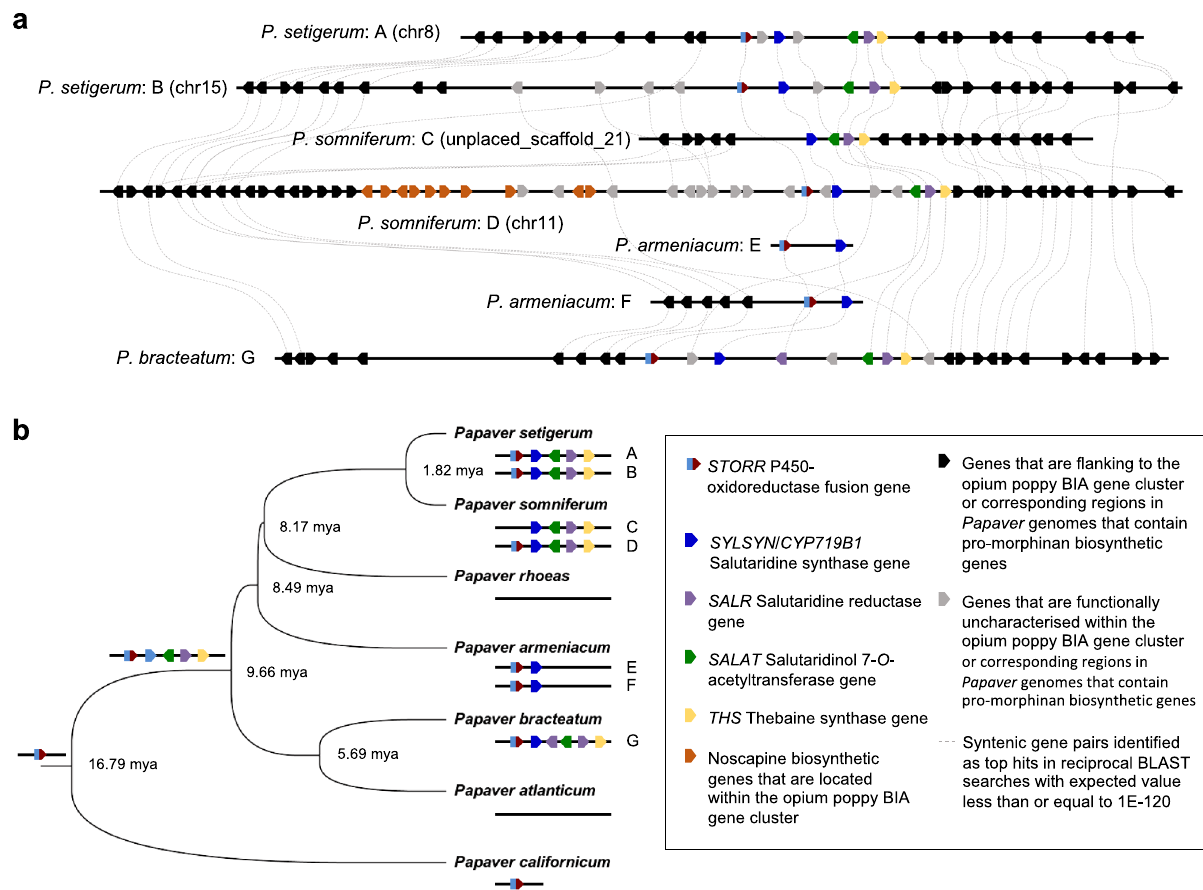
Fig. 4 Evolutionary history of the STORR plus promorphinan component of the BIA gene cluster in Papaver . a Graphic representation of synteny between contigs that contain STORR and promorphinan genes in Papaver genomes. Arrangement of the genes and their orientations of the syntenic regions of Papaver species are shown as indicated in the inset (Supplementary Data 5); including the corresponding regions in the opium poppy genome, one of which contains the BIA gene cluster and its fl anking regions ( P. somniferum : C&D) 5 , the two syntenic regions in the P. setigerum genome on Chromosomes 8 and 15 ( P. setigerum : A&B) 14 ; the two contigs of 94 kb and 294 kb from the P. armeniacum genome ( P. armeniacum : E&F) and the single 1.2 Mb contig of the P. bracteatum assembly ( P. bracteatum : G). Dashed lines denote syntenic gene pairs. b Summary of the evolutionary history of the STORR plus promorphinan genes of the BIA gene cluster in Papaver as inferred from the species phylogeny and synteny in the genomes. The phylogeny for the selected subset of Papaver species and divergent times at the branching points were extracted from the species tree in Fig. 1b. The emergence of STORR and its clustering with all four promorphinan genes are indicated on the ancestral nodes. These are derived from the presence and organisation of these genes in the genomes of these extant species, which are also shown. Source data are provided as a Source Data fi